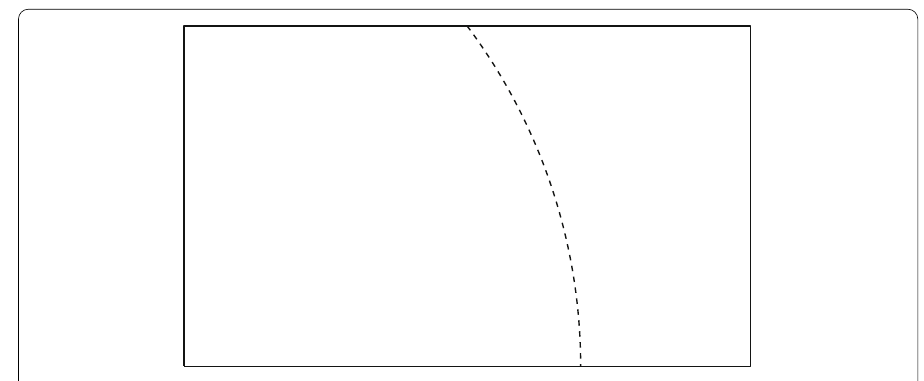
Fig. 2 Element intersected by the boundary (dashed)